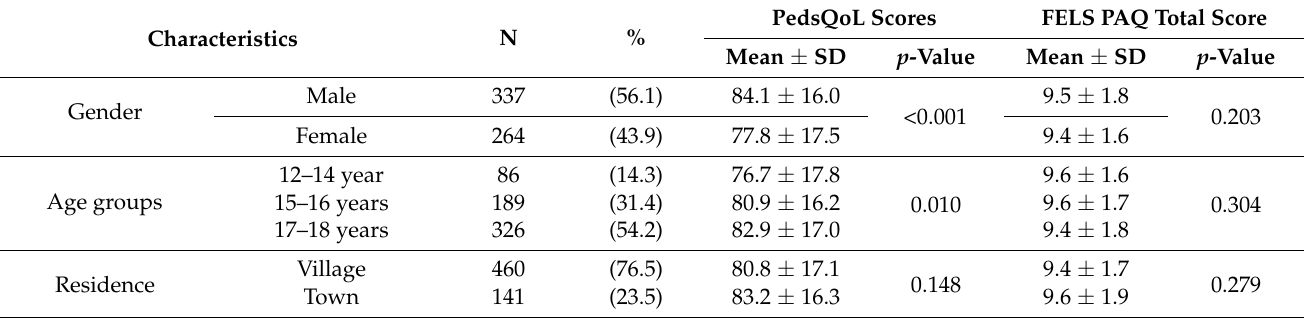
Table 1. Background characteristic, health-related quality of life, and physical activity scores among the study participants (n =